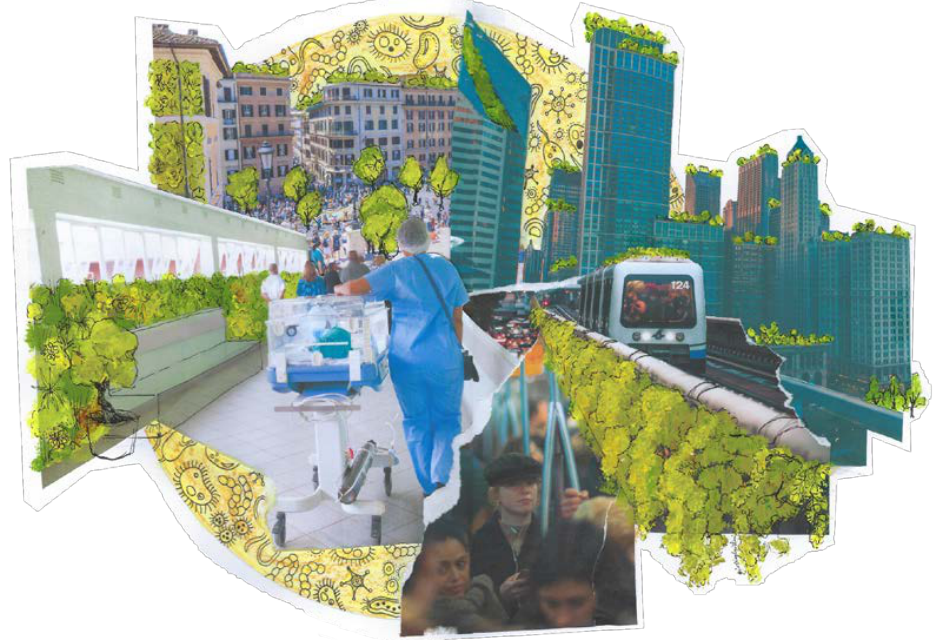
Figure 3. Rewilding today’s urban centers: While designing policies to address the construction of the integrative cities of the future, we will have to transition through an intermediate phase of nature’s inclusion in existing urban areas. This illustration is realized with clippings representing the city of today (a crowded square, clusters of skyscrapers, commuter subway lines, and the core of last year’s public health: hospitals). The figure’s layered structure represents the different tiers we must act on to renovate the current urbanization condition. On top of everything, painted vegetation is inserted in the already existing urban pattern: a call for greener living spaces is becoming increasingly essential. The microbiota (both human and environmental), represented in yellow in the background, envelops everything as the linking element between humans and the context we built and live in. Not only does our health depend on our microbiome, but its composition is heavily affected by environmental changes; just as in a collage, every piece is glued to the